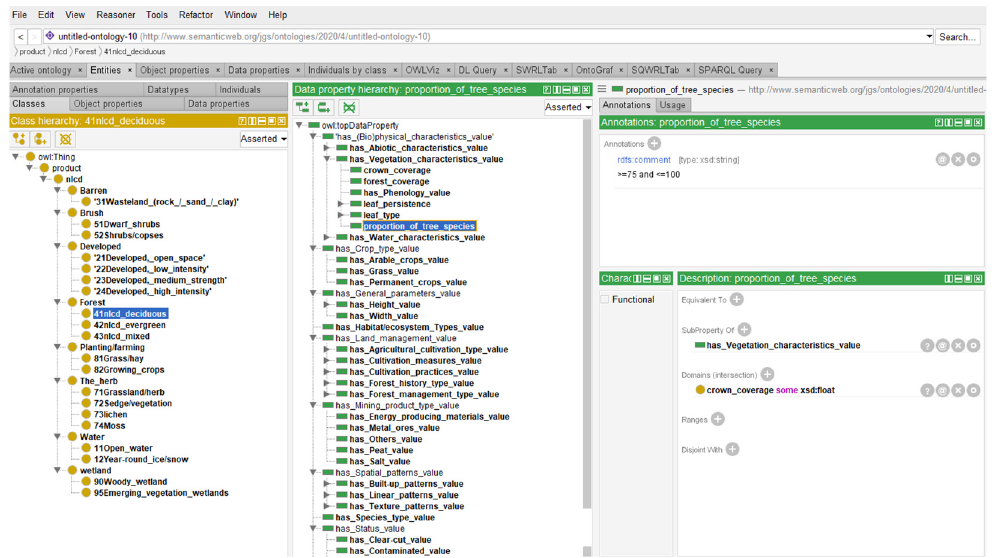
Figure 5. NLCD2011 land-cover ontology.